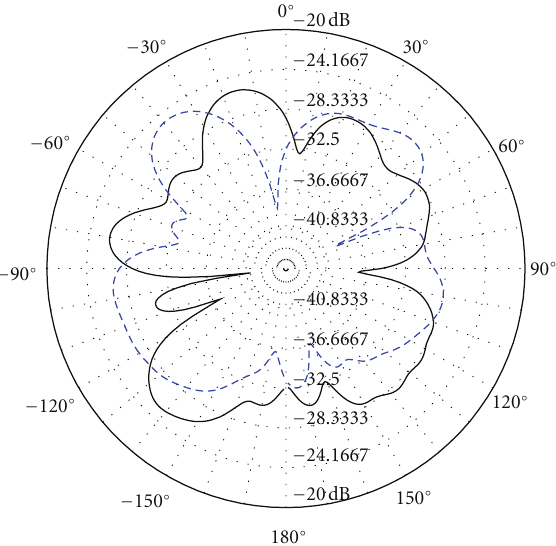
Figure 6: Measured radiation pattern at 2.2GHz on XZ plane (blue) and YZ plane (black).